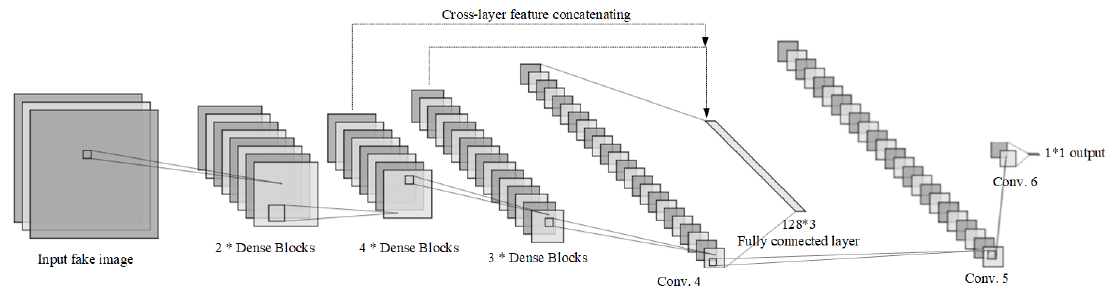
Figure 2. The structure of the proposed common fake feature